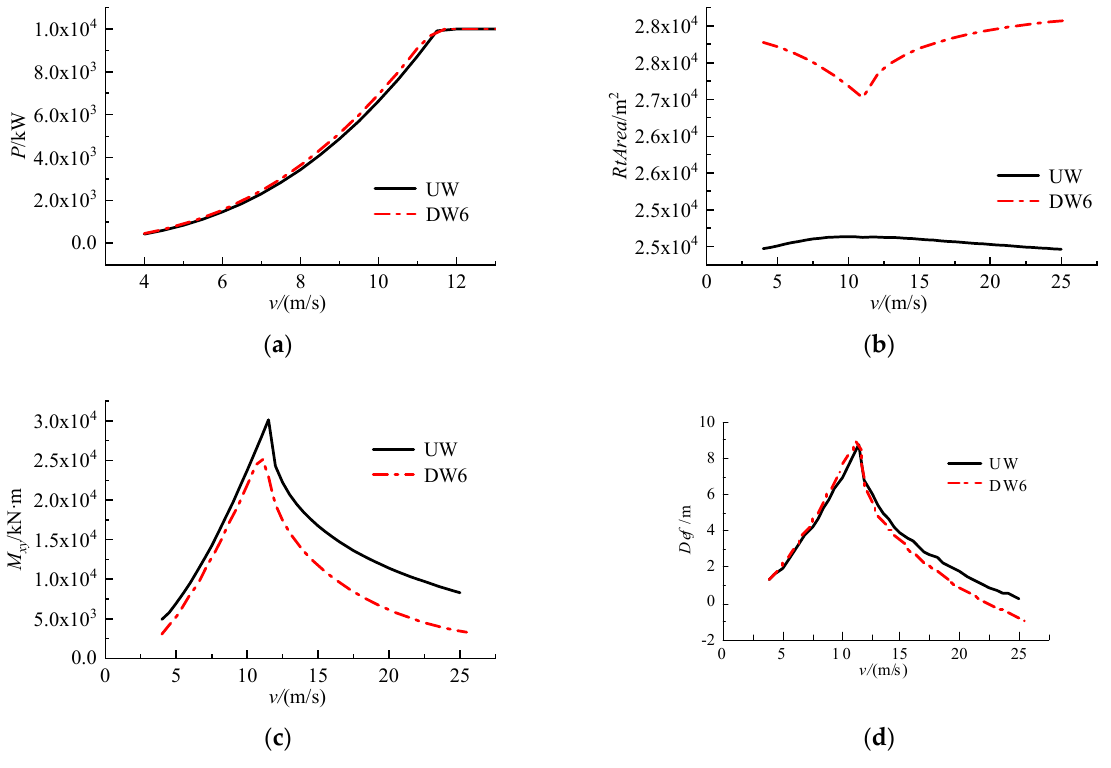
Figure 4. ( a ) Output power curves. ( b ) Rotor swept area curves. ( c ) Loads of blade root curves. ( d ) Blade tip deflection in the flapping direction curves.